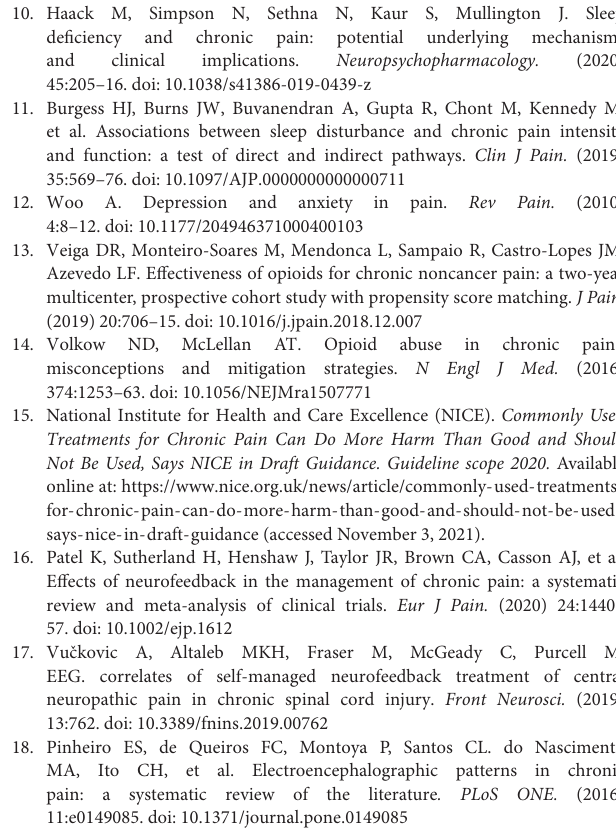
Supplementary Table 1 | Cross-tabulation of the number of patients who reported changes in each EEG band against each pain outcome measure. Chi-square test results comparing correlation of alpha, hi-beta and theta changes with all outcome measures. For all outcome mesures except EQ5D5L VAS, decrease of the score indicates an improvement from pre-to-post intervention. For EQ5D5L VAS, increase of the outcome measure represents improvement in quality of life from pre-to-post